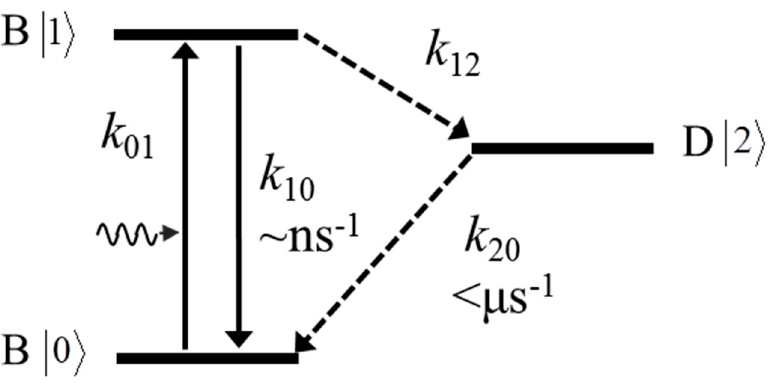
Figure 2. Electronic states of a fluorescence molecule and the transition rate between them. A typical three-level system is presented, including a ground state |0>, an excited state |1>, and a dark state |2>. Refer to the text for a detailed description.